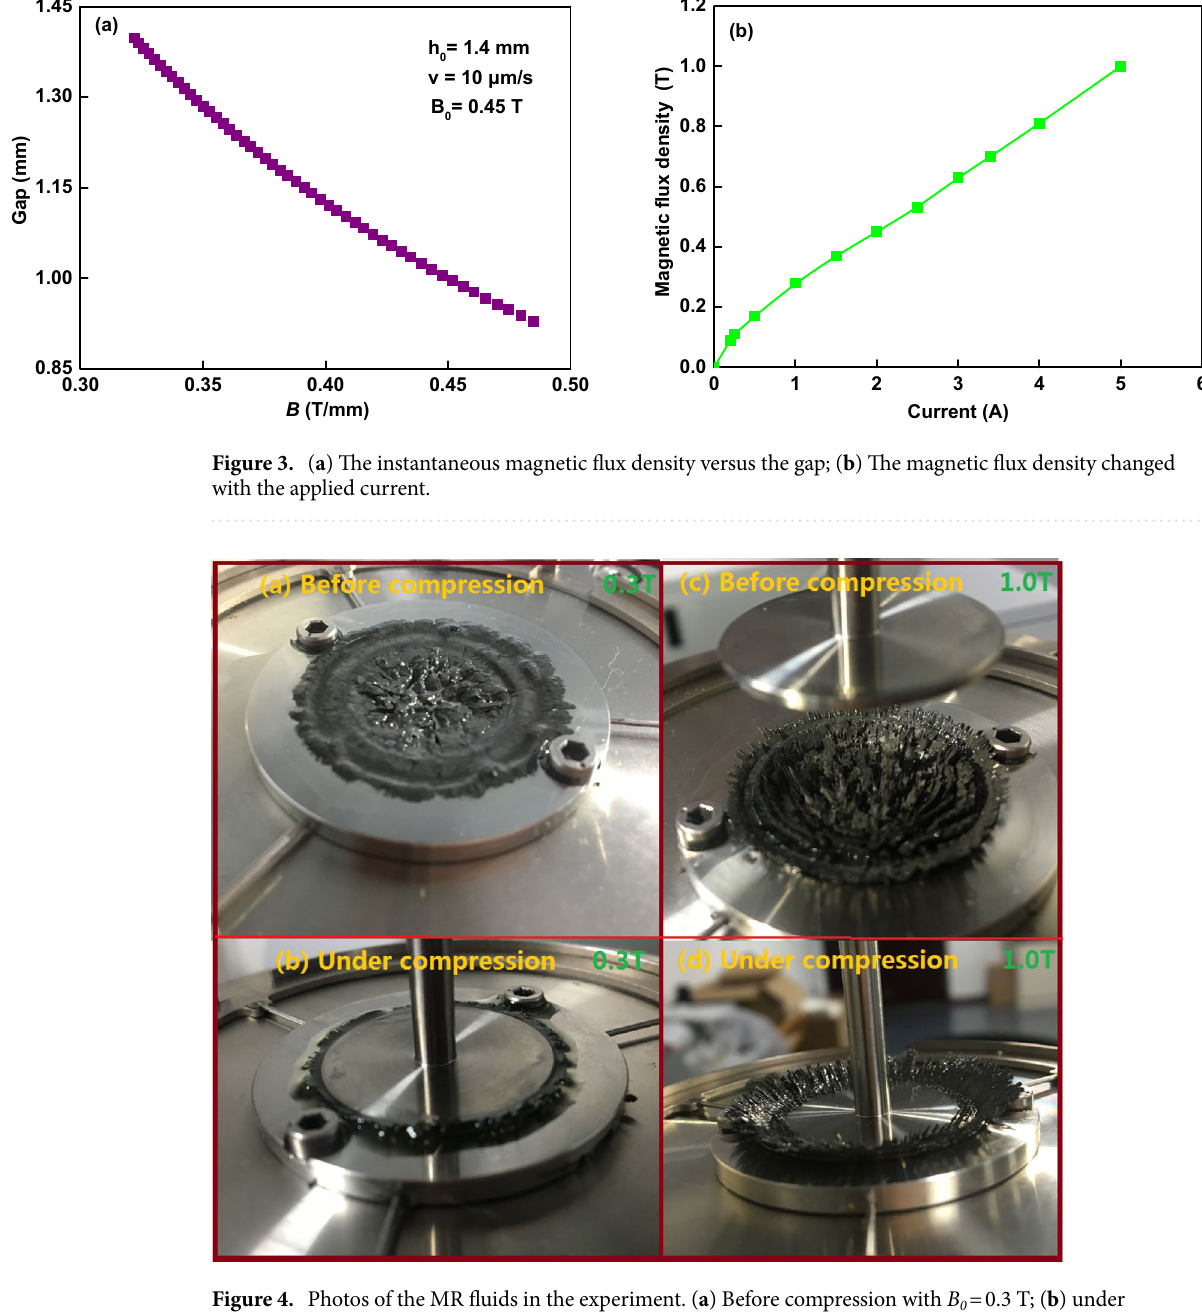
Figure 4. Photos of the MR fluids in the experiment. ( a ) Before compression with B 0 = 0.3 T; ( b ) under compression with